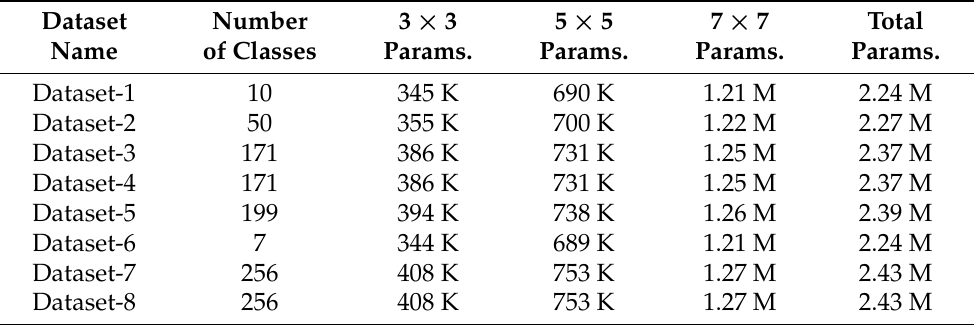
Table 3. The number of classes and number of parameters for individual and BengaliNet architectures for all the